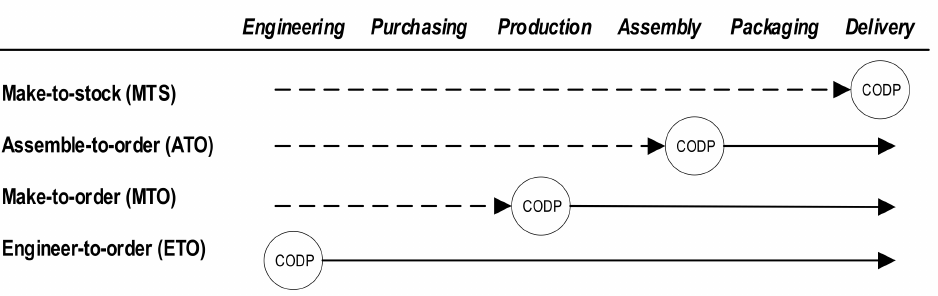
Figure 2. CODP, also known as freeze point or order penetration point. This refers to the point in the value chain at which a customer triggers a company’s activities [28]. All activities before the CODP share a forecast-driven, push-based approach (dotted lines/arrows). Activities after the CODP are characterized by a customer-driven, pull based approach (continuous